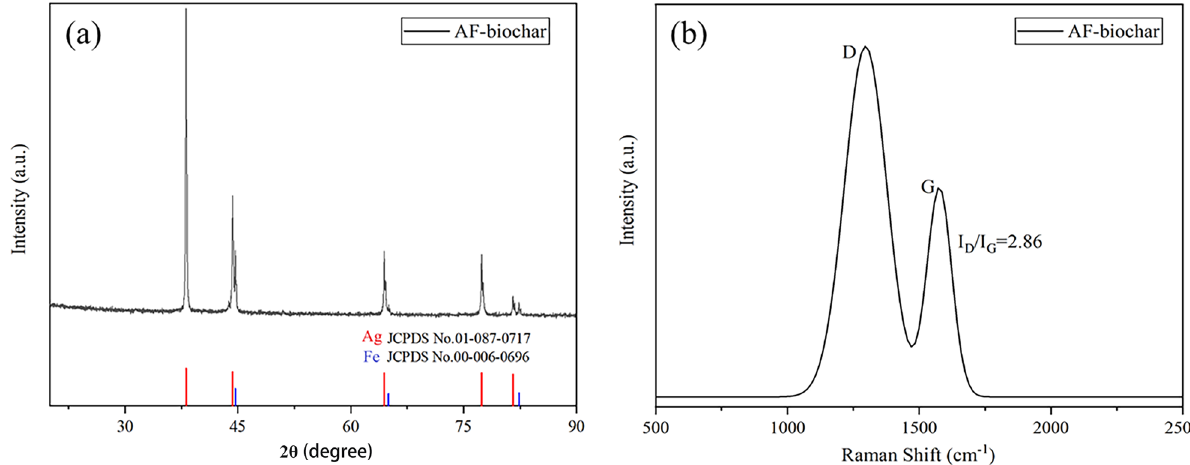
Figure 3: ( a ) XRD pattern of AF - biochar; ( b ) Raman spectra of AF -